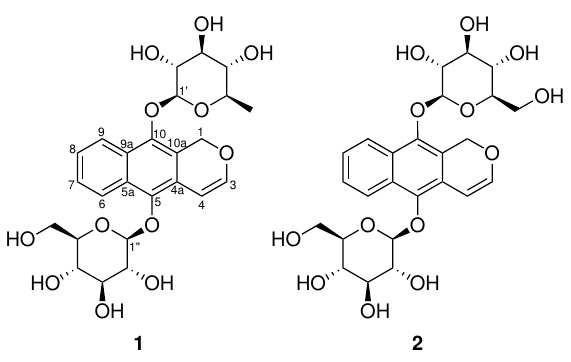
Figure 1. Structures of clarinoside ( 1 ) and harounoside ( 2 ).